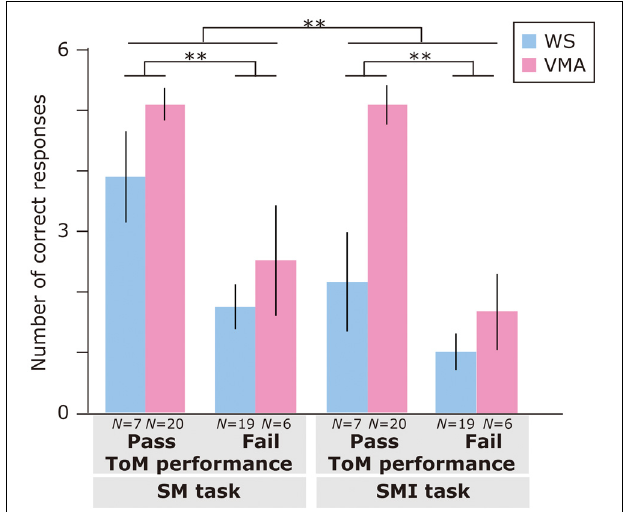
FIGURE 7 | Mean number of correct trials (max: 6) in the SM and SMI tasks based on ToM task performance for two groups [blue: Williams syndrome (WS) group; pink: verbal mental age-matched (VMA) group]. Error bars indicate standard error. ∗∗ p < 0 .